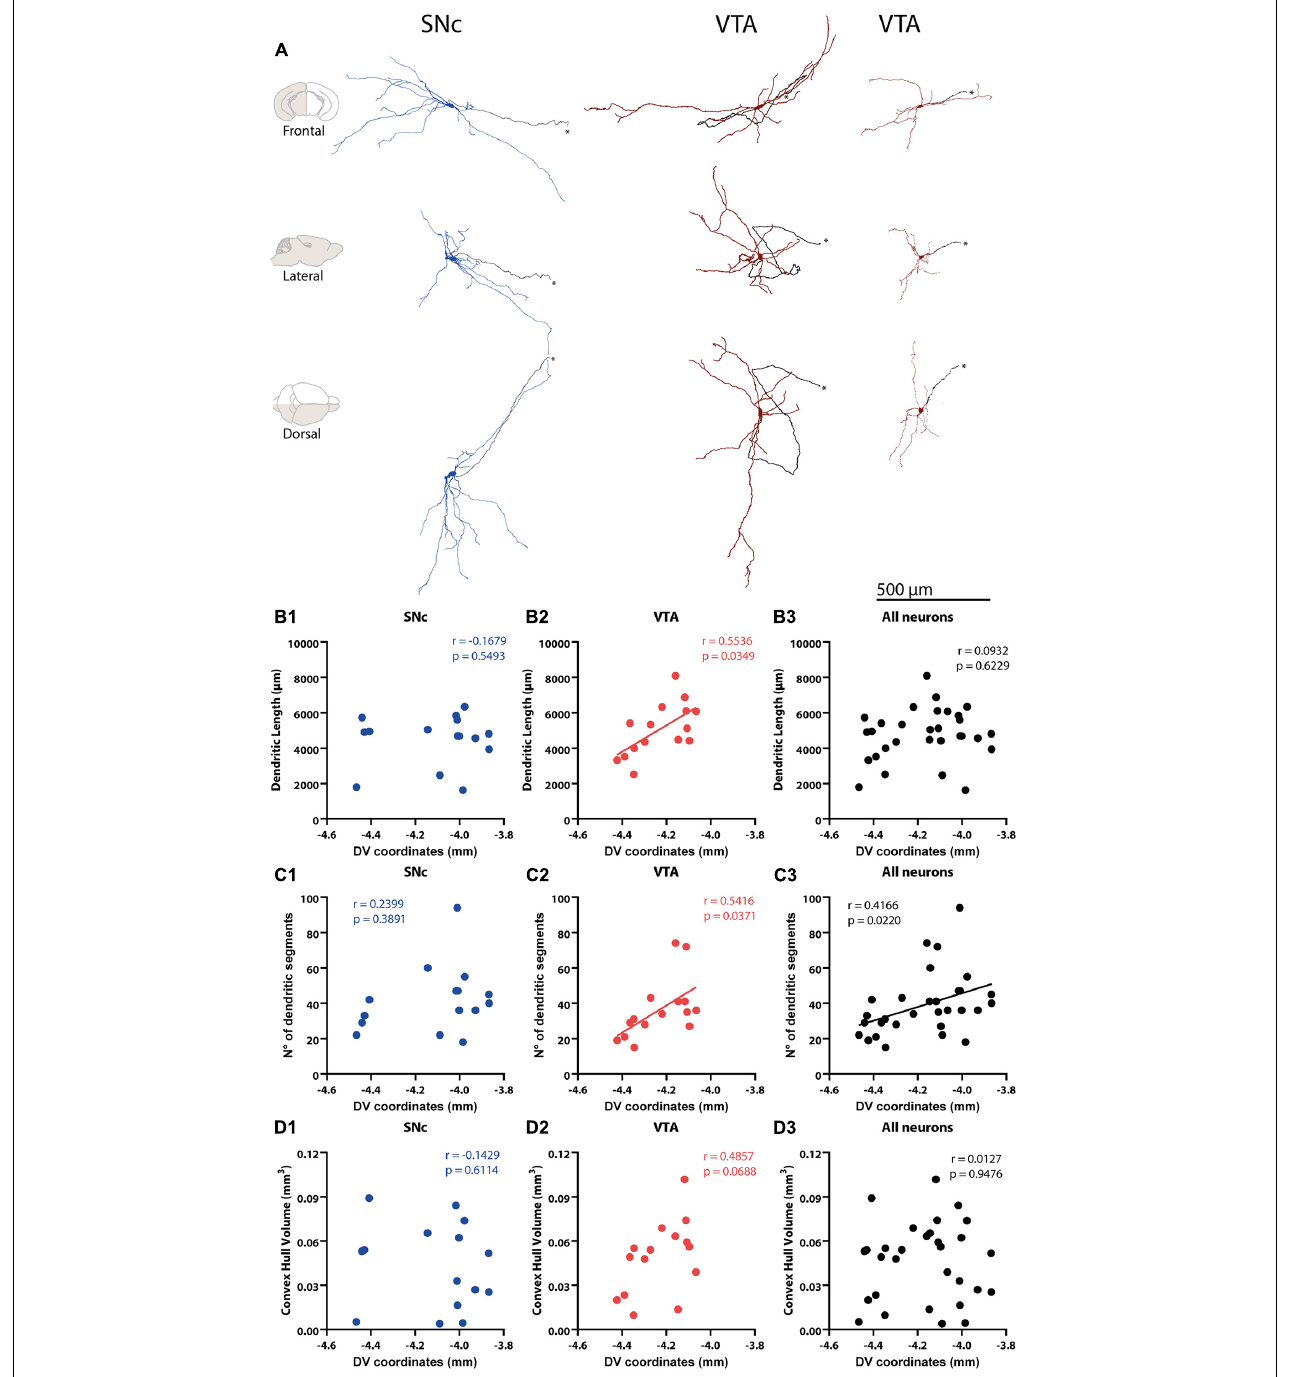
FIGURE 2 | Reconstruction and correlation between morphological characteristics and cell body localization. (A) Identified SNc and VTA DA neuron 3D reconstructions. Arranged in columns, one SNc, and two VTA DA neurons are shown from the frontal (top), lateral (middle), and dorsal (bottom) views. Axons are shown in black in all panels and pinpointed with an *. Brain diagrams to the left indicate hemisphere depicted (in gray) and view. (B1–D3) Correlations between physical (dendritic length, convex hull) and topological (number of dendritic segments) measures and cell body position of 3D reconstructed SNc and VTA DA neurons. A positive correlation was found between total dendritic length and DV coordinates of VTA neurons (B2) , but this was not observed for SNc (B1) or all DA neurons pooled together (B3) . Number of dendritic segments and DV coordinates were positively correlated in VTA (C2) , and when all neurons were pooled together (C1) with no correlation observed for SNc DA neurons (C2) . No correlation was found between convex hull volume and DV position with all DA neurons (D1) , or for SNc (D2) , VTA (D3) for all DA neurons (D1) . Figure only shows correlations between morphology and DV position. Refer to the Results section and Supplementary Table 1 for correlations between morphology and mediolateral (ML) and anteroposterior (AP) axis positions.